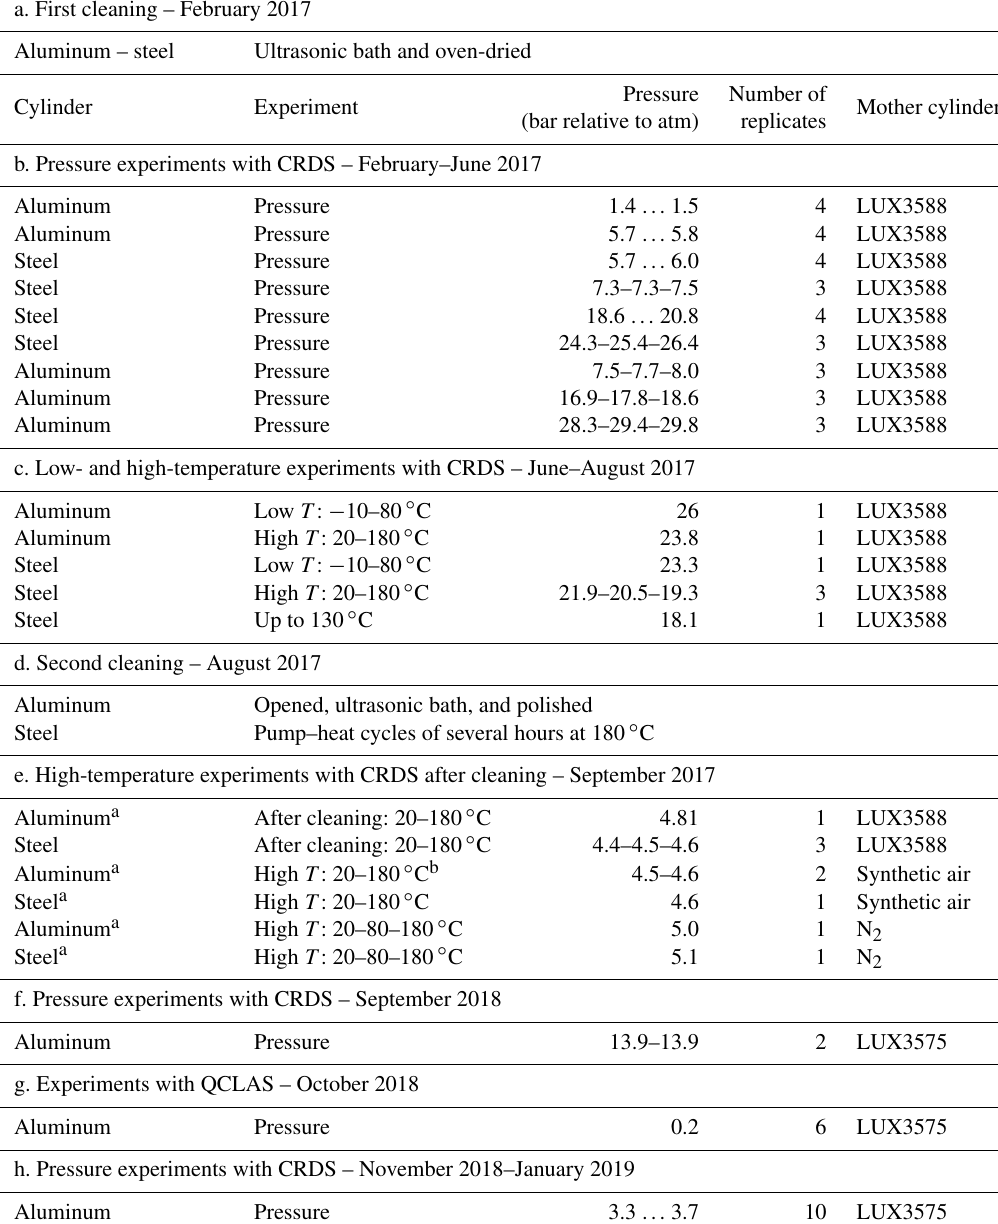
Table 1. An overview of experiments and procedures included in this study in chronological